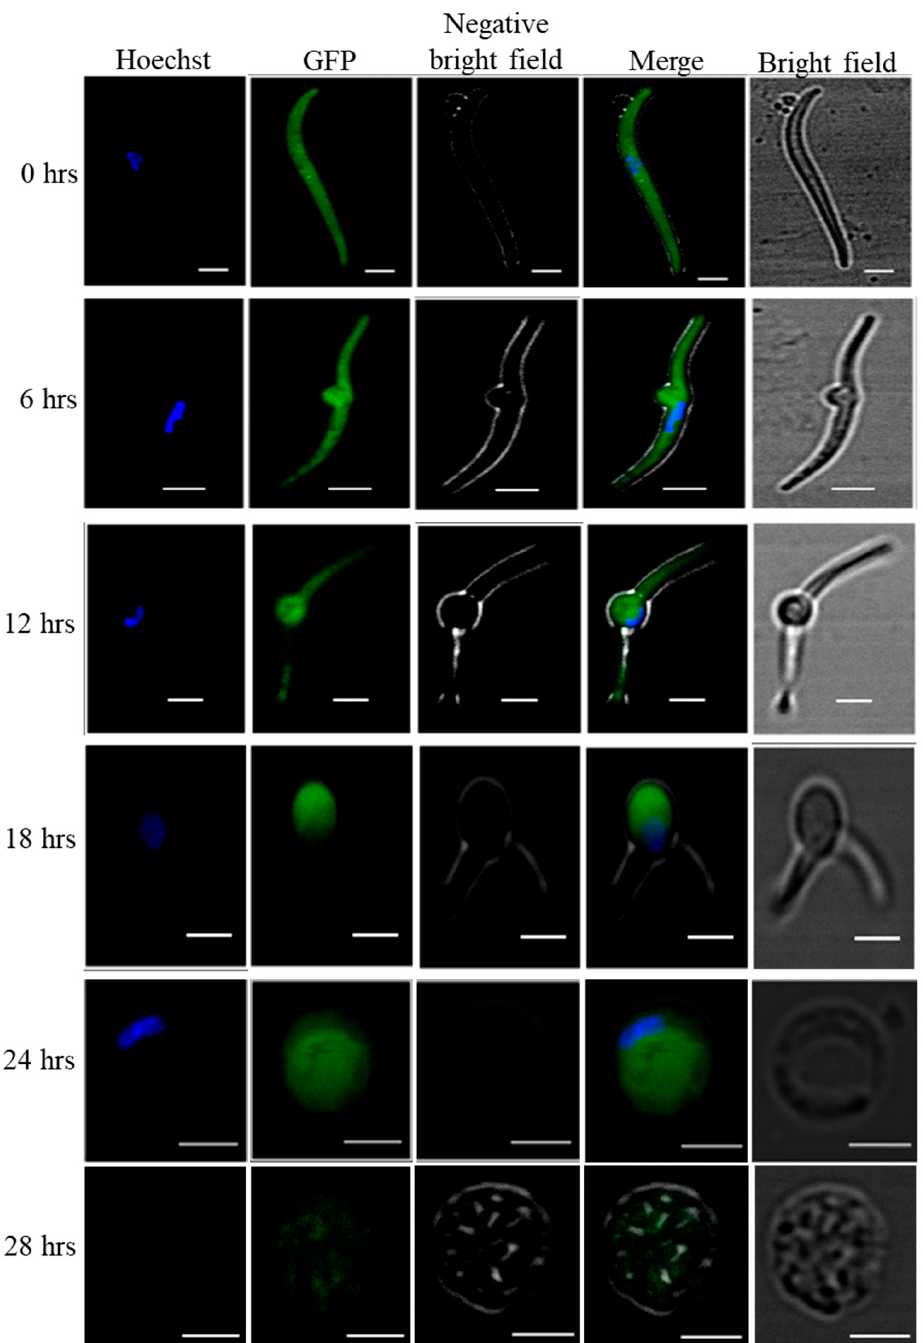
Figure 1. Axenic transformation of eGFP expressing P. yoelii p230p( − ) salivary gland sporozoites into LS. In-vitro host cell free cultured salivary gland sporozoites completely transform into early LS after 24 hrs of incubation. To follow the cell free transformation of salivary gland sporozoites into early exoerythrocytic forms, we used eGFP expressing Pyp230p( − ) and followed the transformation by confocal microscopy of cultured sporozoites at 6 hrs intervals for 24 hrs. At 28th of Axenic LS culture we could not find any good GFP images. Scale bars 2 µ